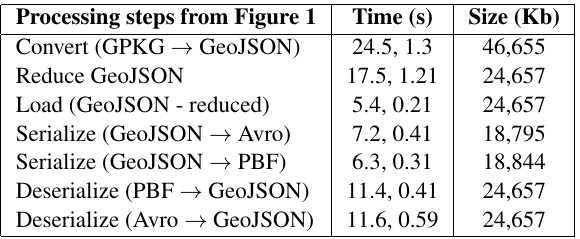
Table 4. Results of Experiment 3 using the reduced GPKG file: mean and standard deviation of the time required for each processing step and size of the resulting